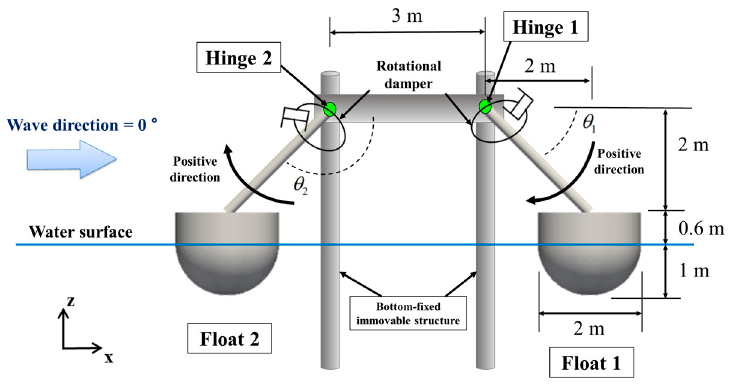
Figure 12. Model description of a two-buoy HPA-type WEC with constrained hinge points.